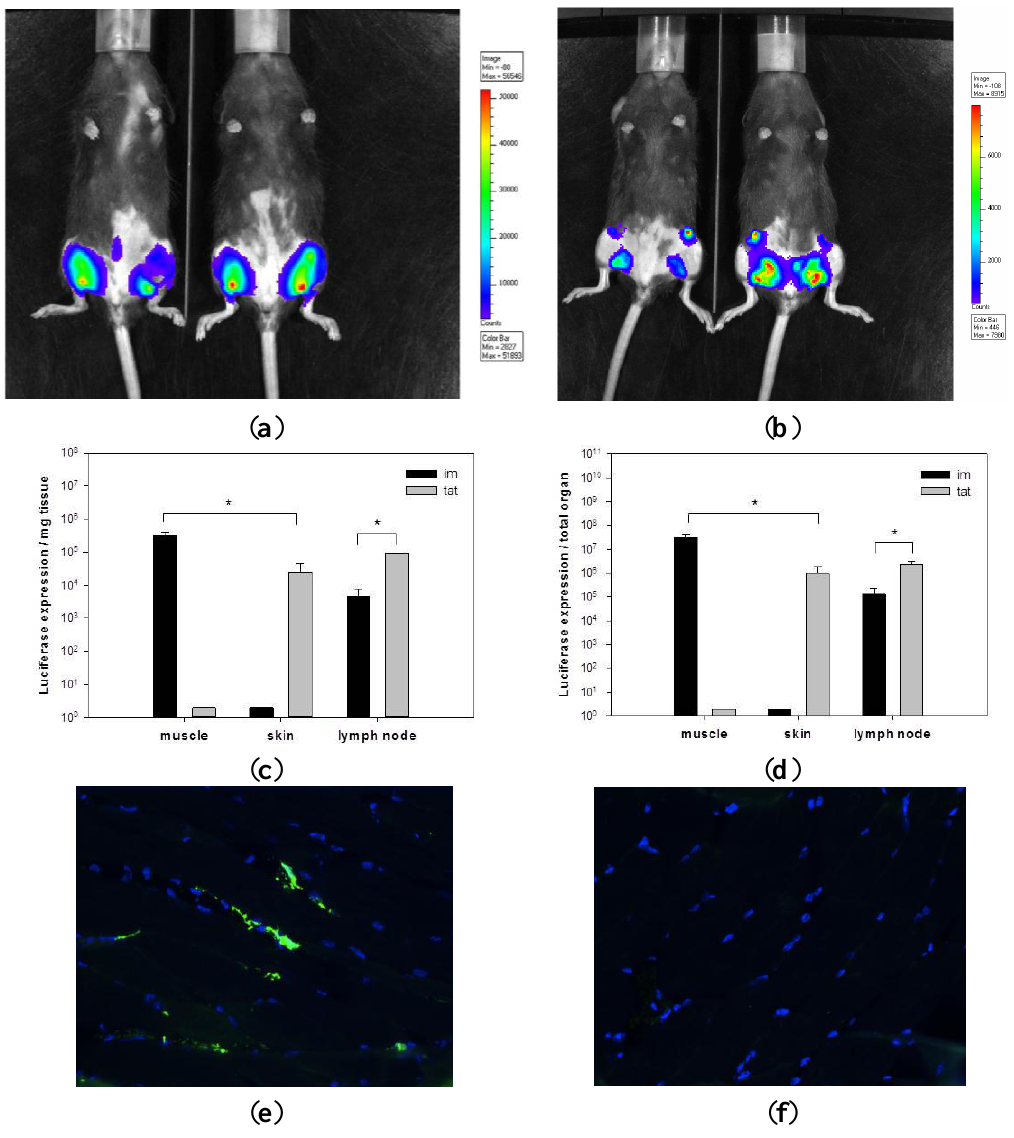
Figure 1. Tattooing of rSFV replicon particles results in high transgene expression. Luciferase expression by SFVLuc was determined in vivo with bioluminescence imaging using a CCD camera. Mice were tattooed ( a ) or injected intramuscularly ( b ) with 10 7 i.u. of SFVLuc. After 6 h, images with an integration time 30 s were taken. Blue colors represent the least and red colors represent the most intense light intensity. Two representative mice for each group are shown. Immediately after in vivo measurements, animals were sacrificed and muscles from the intramuscularly treated group or skin from the tattooed group and draining inguinal lymph nodes were isolated for ex vivo luciferase expression. Luciferase expression is shown as expression per mg organ ( c ) or per total organ ( d ) ( n = 4). Data of a representative experiment out of two are shown. * p < 0.05. Mice were intramuscularly injected with 10 8 i.u. of SFV-EGFP ( e ) or PBS ( f ). After 24 h, skin and muscle from the site of administration were excised and analyzed by immunofluorescence staining. For immunofluorescent staining, muscle tissue expressing EGFP were analyzed using anti-GFP antibody (green). Cell nuclei were detected using DAPI (blue) (magnification 40×). A representative image for each group is